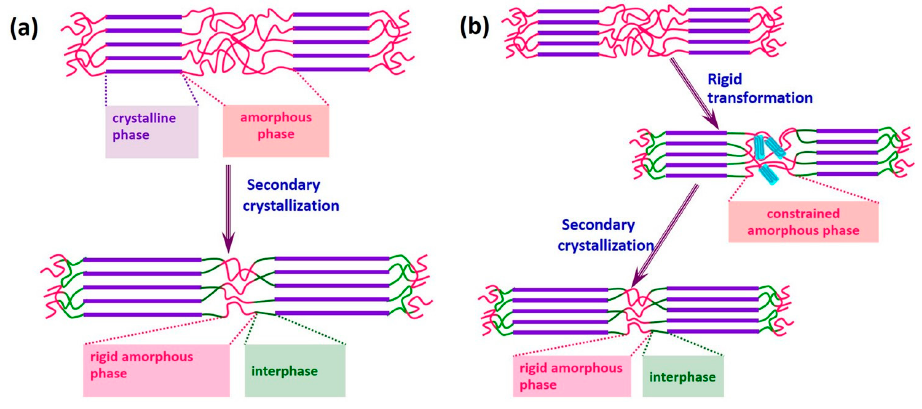
Figure 3. Brittle evolution mechanism for PHBHV: ( a ) secondary crystallization; ( b ) rigid transformation for amorphous